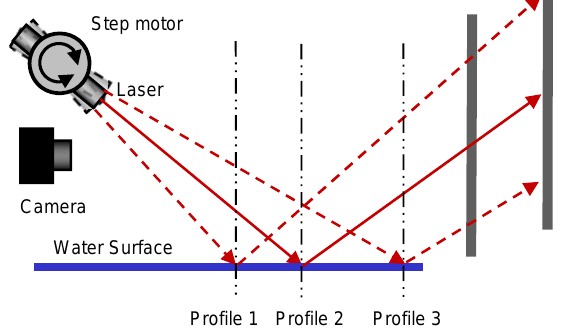
Figure 14: Variable setting of laser light sheet.